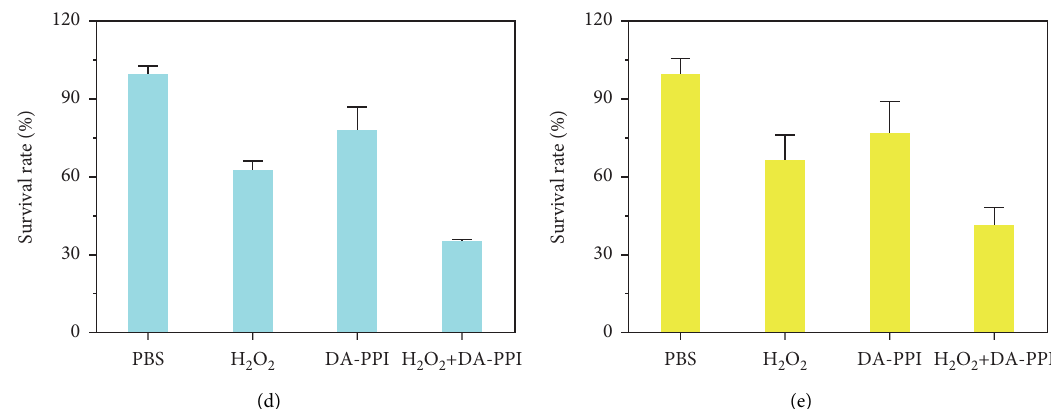
Figure 7: Te possible antibacterial mechanism of DA-PPI nanozyme (a). LDH release after treatment 12 h in absence or presence of DA- PPI or DA-PPI with 0.5 mM H 2 O 2 (b). Photographs of bacterial colonies of E. coli and S . aureus in diferent groups (c). Te survival of E. coli in diferent groups (d). Te survival of S . aureus in diferent groups (e).